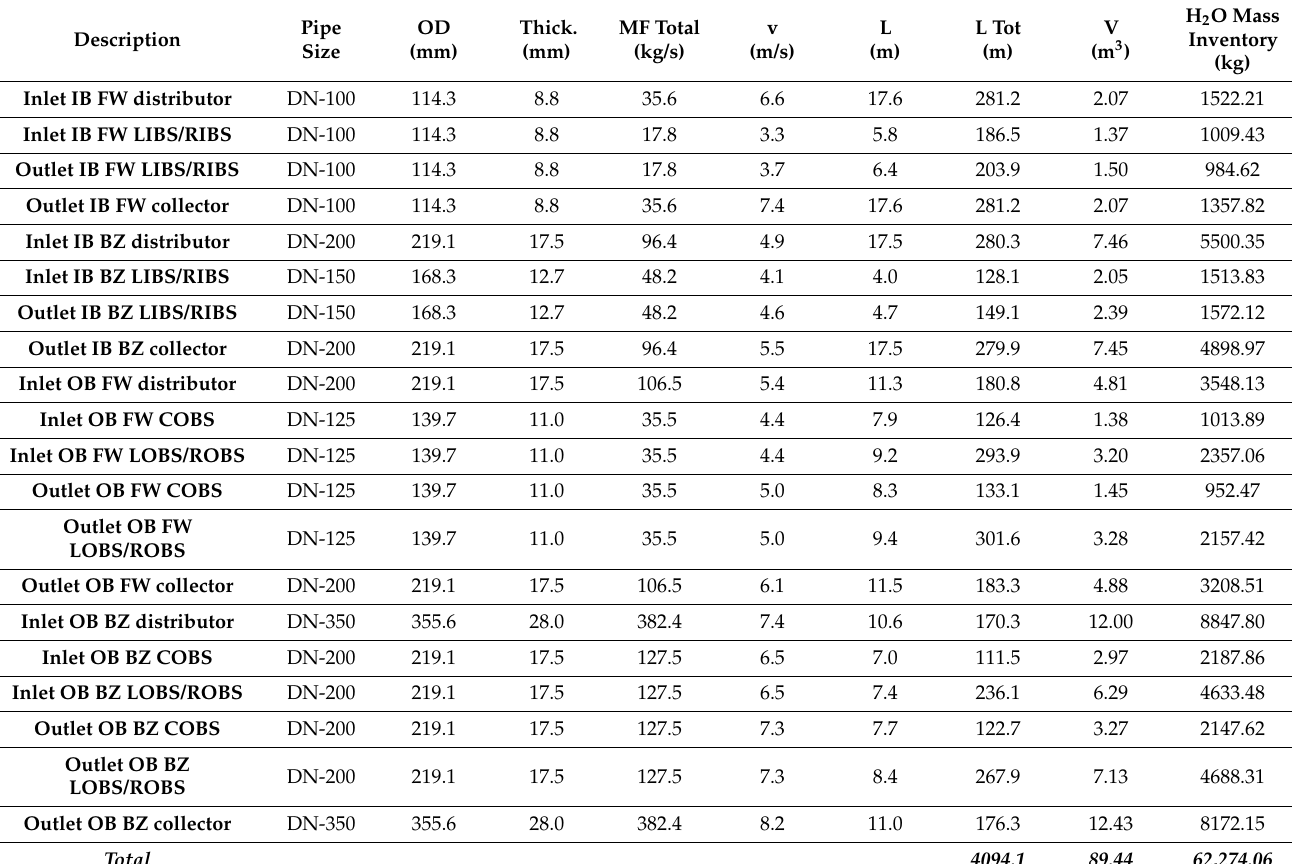
Table 6. WCLL BB In-Vessel